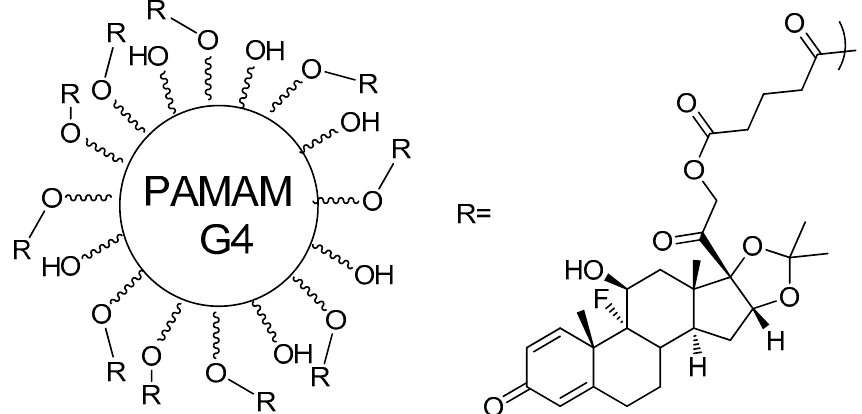
Figure 6. PAMAM-G4 functionalized with 10 molecules of triamcinolone acetonide attached, and glutaric acid as spacer agent [65,68].